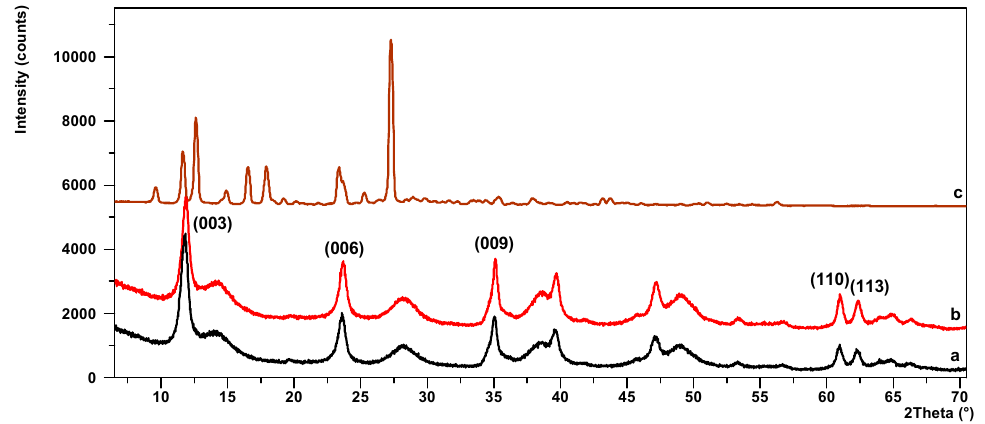
Figure 4. Powder XRD patterns for LH ( a ), LH / lawsone ( b ) and lawsone ( c ).